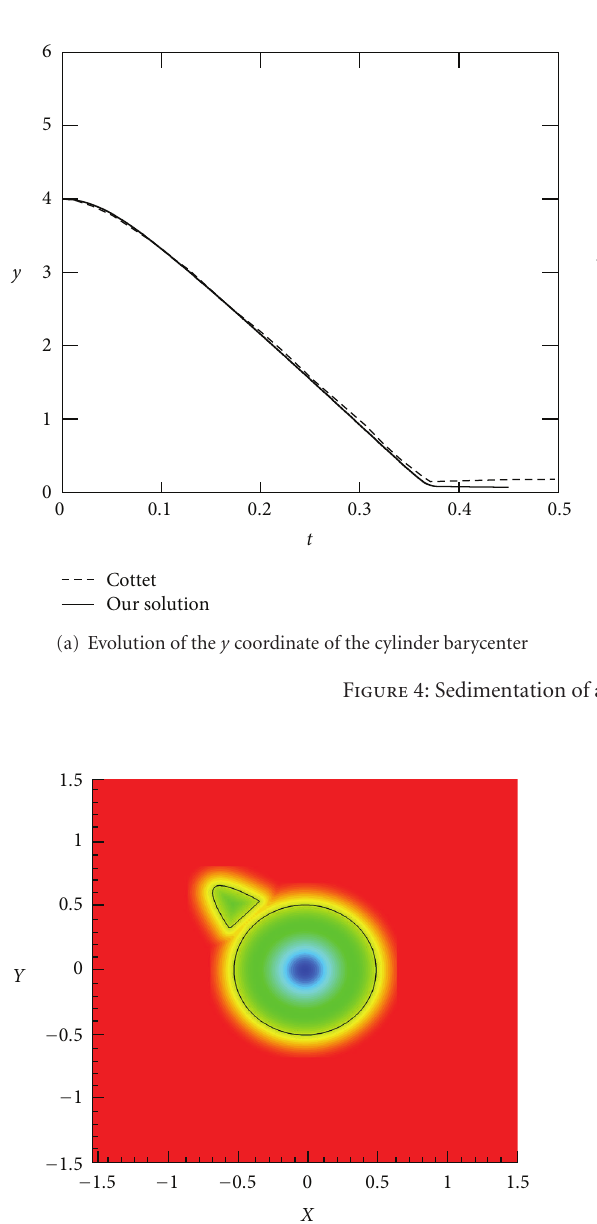
Figure 5: Cylinder distance level set function (negative inside the bodies positive outside) used in the penalization: iso-line 0 in black (color map from − 0.5 in blue to 0.25 in red).